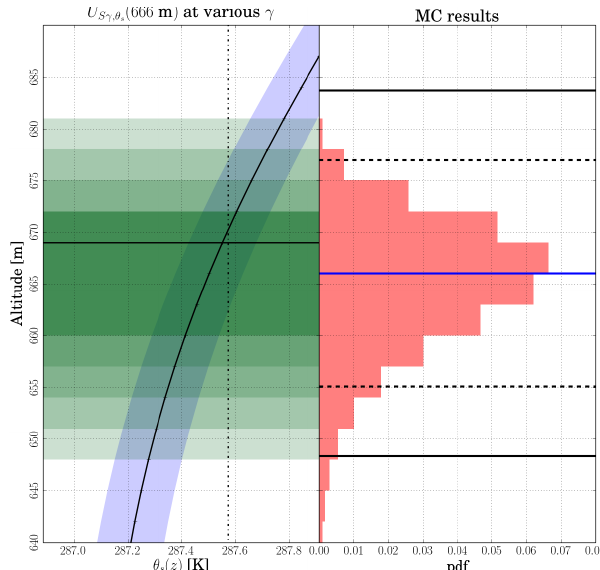
Figure 5. Left panel: the strict confidence neighborhoods U Sγθ (x m ) and the true MH as a horizontal black line. For color s scales for different γ values see Fig. 3. Right panel: the distribution of the Monte Carlo output as a probability density function (pdf). The blue line is the median of the distribution, the dashed lines de- fine the localization error of the median as from Eq. (7), and the solid lines represent the square root of the second-order moment about the median of the